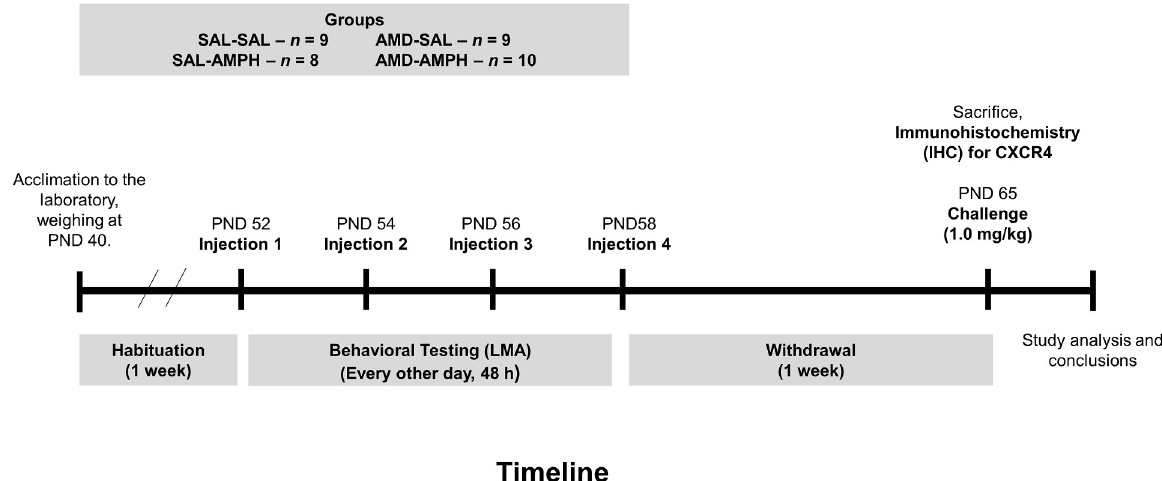
Fig 1. Timeline that depicts for the experimental design and procedures used in the current study. Animals were habituated to the laboratory setting for one week prior to the start of testing. Following this, animals were placed in the LMA chambers for a 15 min habituation, and then given a pretreatment (SAL, 0.9% NaCl, IP) or (AMD,4.0 mg/kg, IP). This was followed by drug treatment, (SAL or AMPH 4.0 mg/kg, IP) at 30 min, every 48 h for four days. One week after the final day of testing, which was the withdrawal period, all animals were challenged with a